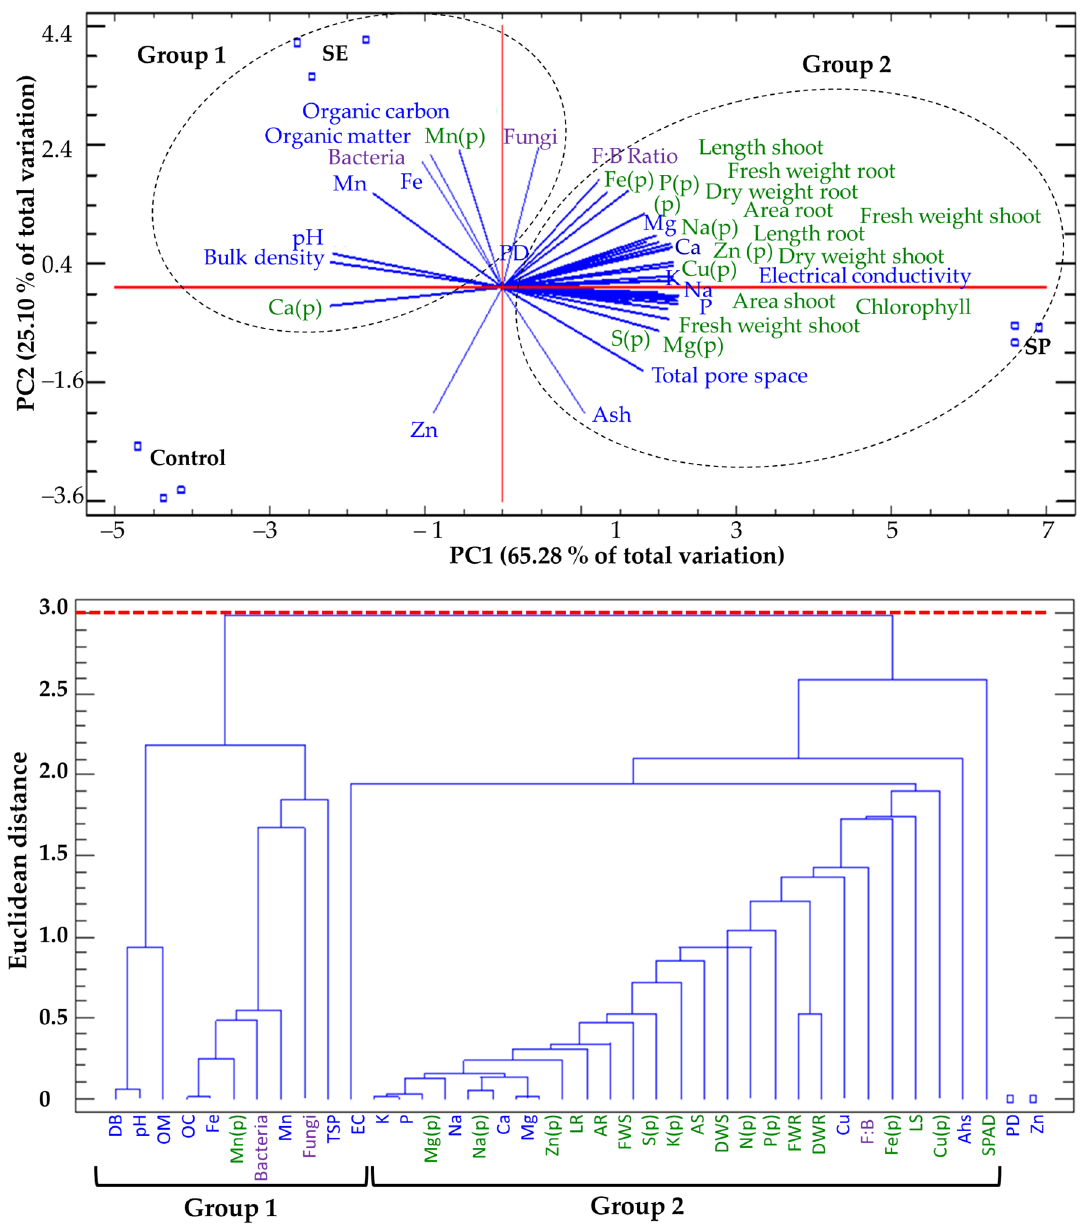
Figure 5. Principal component analysis (PCA) and dendrogram classification based on the physic- ochemical characteristics of substrates treated with seaweed powder (SP) or seaweed extract (SE) and the control substrate on soil microbes (fungi and bacteria) and the growth and physiological characteristics of tomato plants after a 45-day experiment. The physicochemical (blue letters), soil microbiological growth (purple letters), and morphological and biochemical (green letters) character- istics of the substrates used to grow tomato plants are shown.